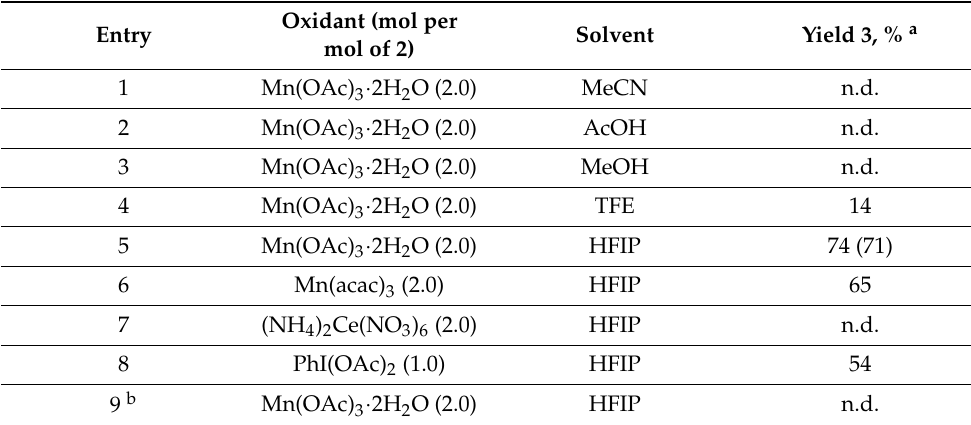
Table 1. Optimization of the reaction